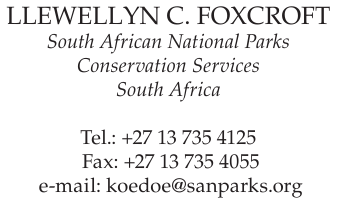
Fig. 1b Koedoe’s front cover in 1987.